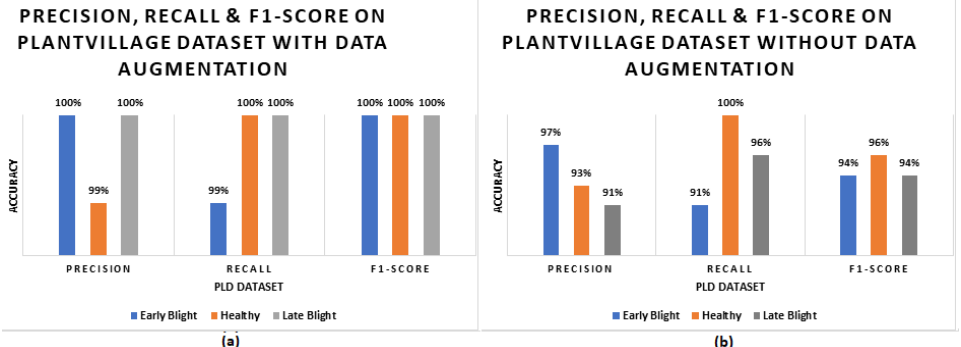
Figure 14. ( a ) PDDCNN precision, recall and F1-Score on PlantVillage with data augmentation. ( b ) PDDCNN precision, recall and F1-Score on PlantVillage without data